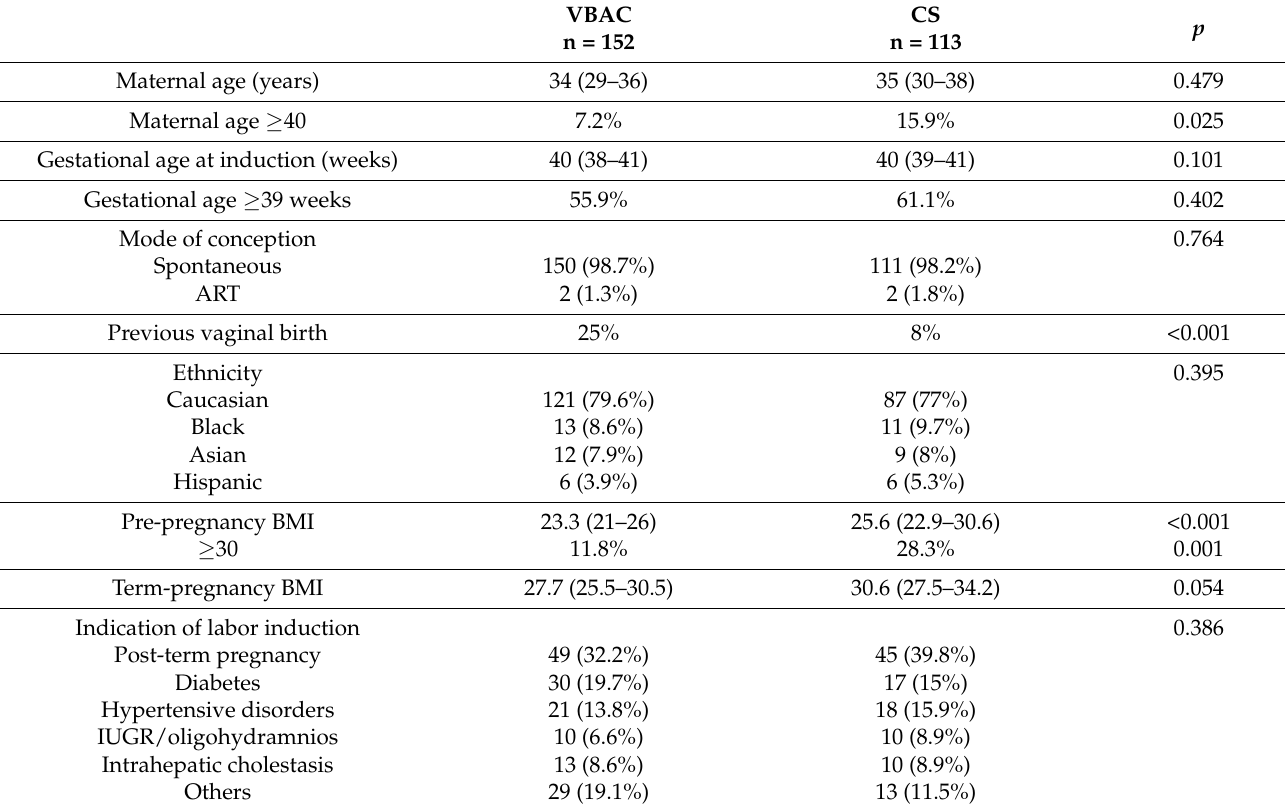
Table 2. Characteristics of women undergoing labor induction and related labor outcomes: compari- son between 152 women delivering by vaginal birth (VBAC) vs. 113 requiring